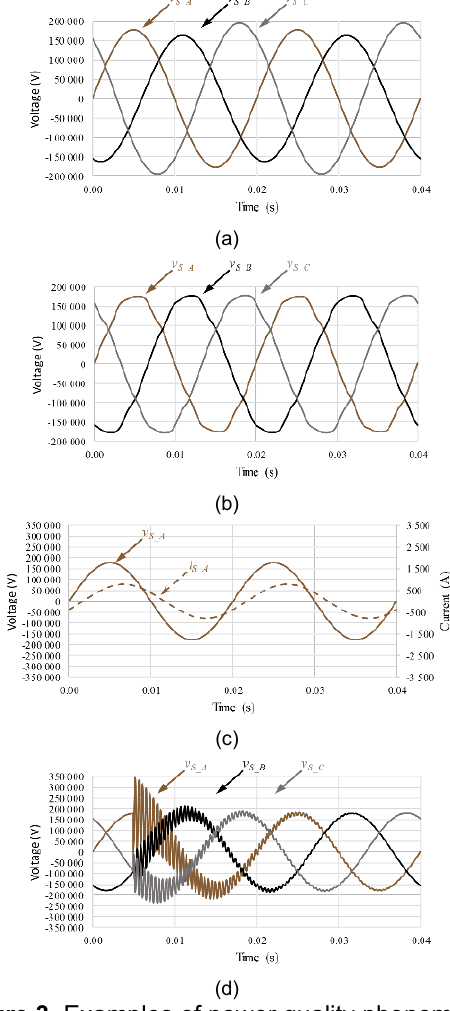
Figure 3. Examples of power quality phenomena: (a) Voltage unbalance; (b) Voltage harmonics; (c) Low power factor; (d) Voltage